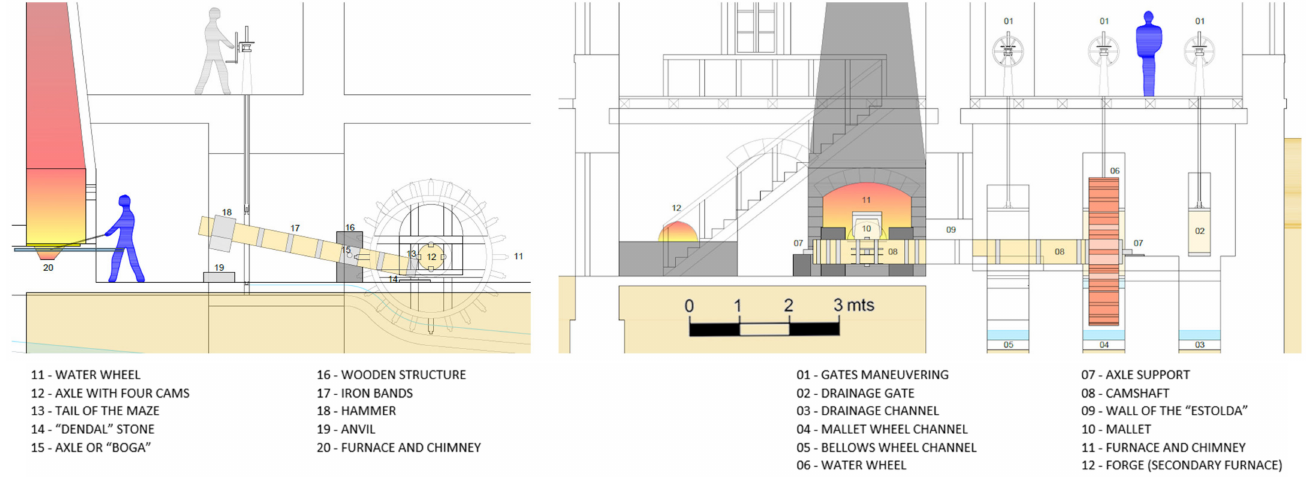
Figure 15. Handle room. Source: own